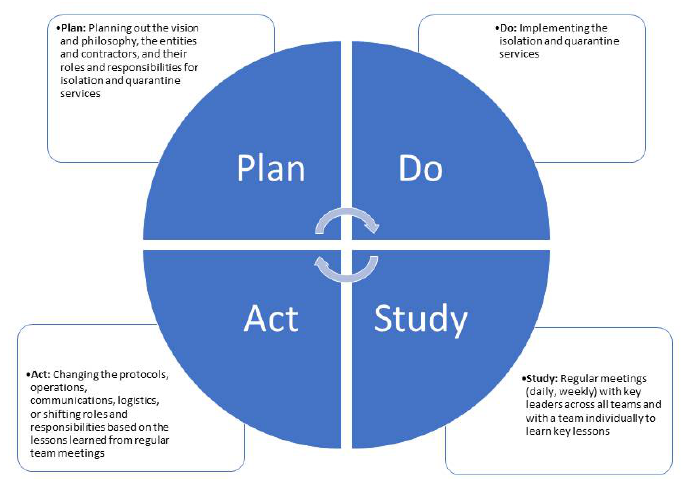
Figure 1. PDSA Cycle. Notes: the PDSA cycle was adapted and utilized for the purpose of creating and implementing a system that allowed for a structured quality improvement regime and allowed for constant analysis and changes.